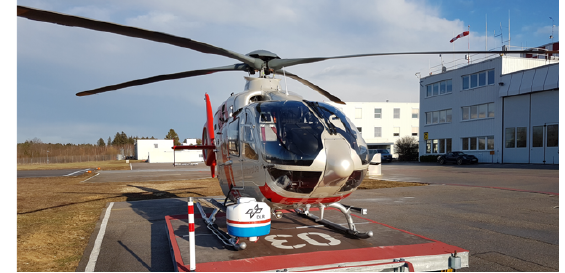
Figure 3. DLR 4k camera system mounted on the fuselage of a EC135